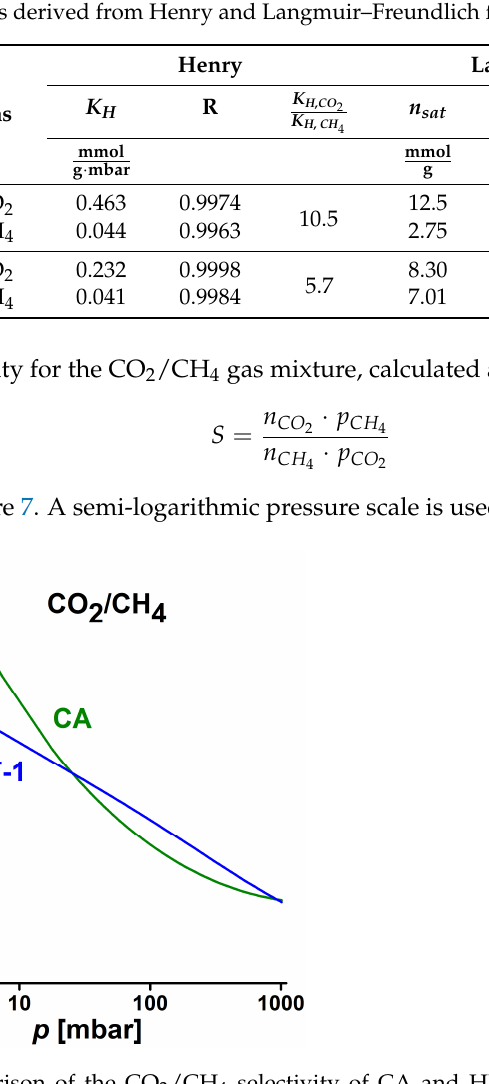
Figure 7. Comparison of the CO 2 /CH 4 selectivity of CA and HKUST-1 from IAST using the Langmuir–Freundlich fit of the